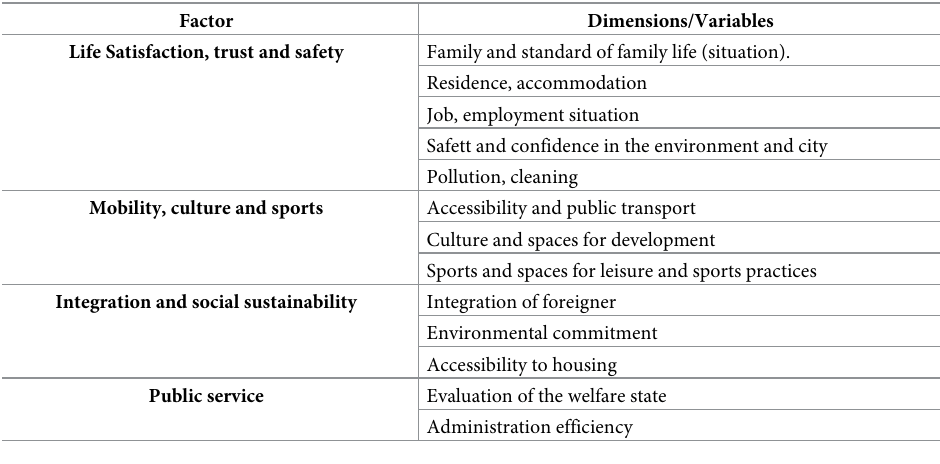
Table 1. Quality of life